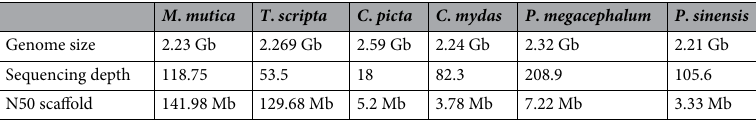
Table 1. Basic statistics of sequenced turtle